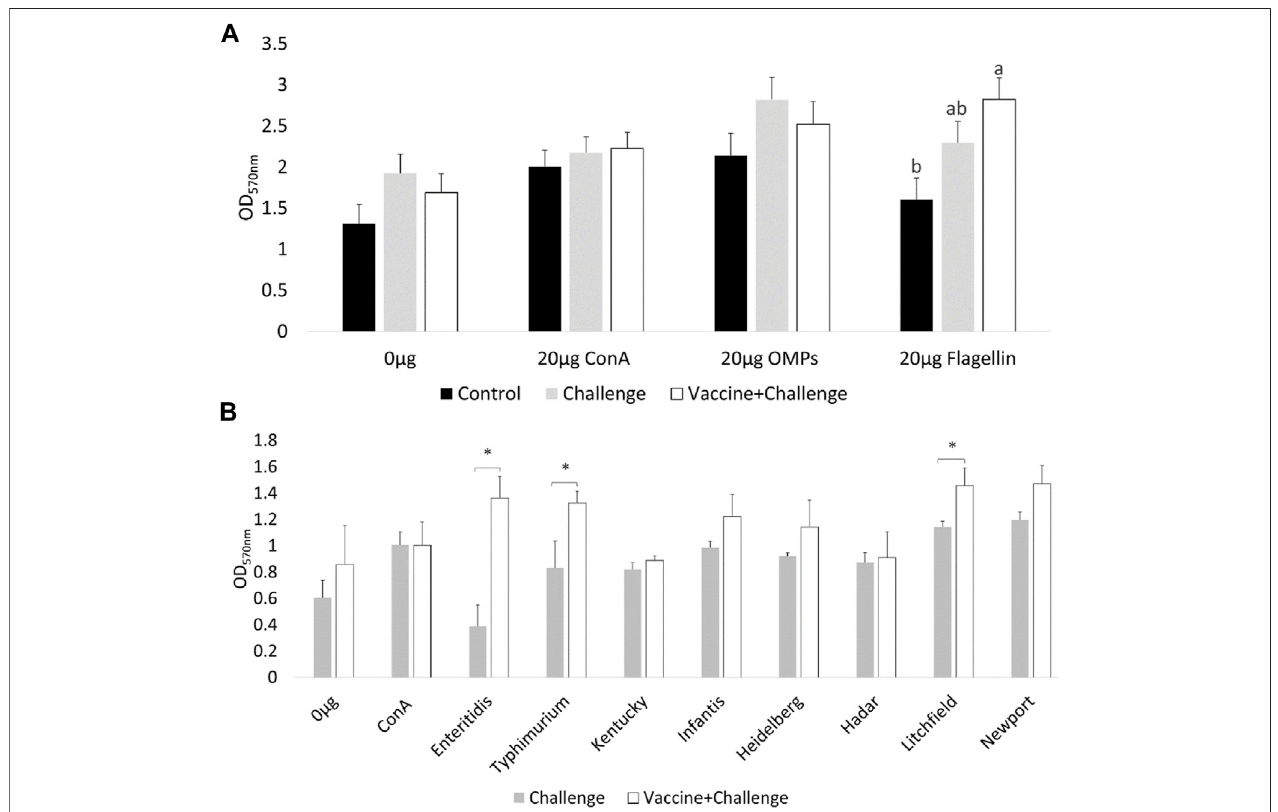
FIGURE 1 | Ex-vivo recall-response of spleenocytes of vaccinated birds. At d12 of age, splenocytes PBMCs were stimulated with either 20 μ g/ml OMP, 20 μ g/ml Flagellin or 20 μ g/mlproteins ofdifferent S . Enterica serovars HKA for 3 days. As a negativecontrol splenocytes were stimulated with 0.0 μ g/ml of antigen. As a positive control splenocytes were stimulated with 20 μ g/ml Con A. (A) OMP and Flagellin. Bars (+SE) with no common superscript differ ( p < 0.05); (B) HKA from S. Enterica serovars. Means + SE Bars. n = 6. “ * ” signi fi es p < 0.05.